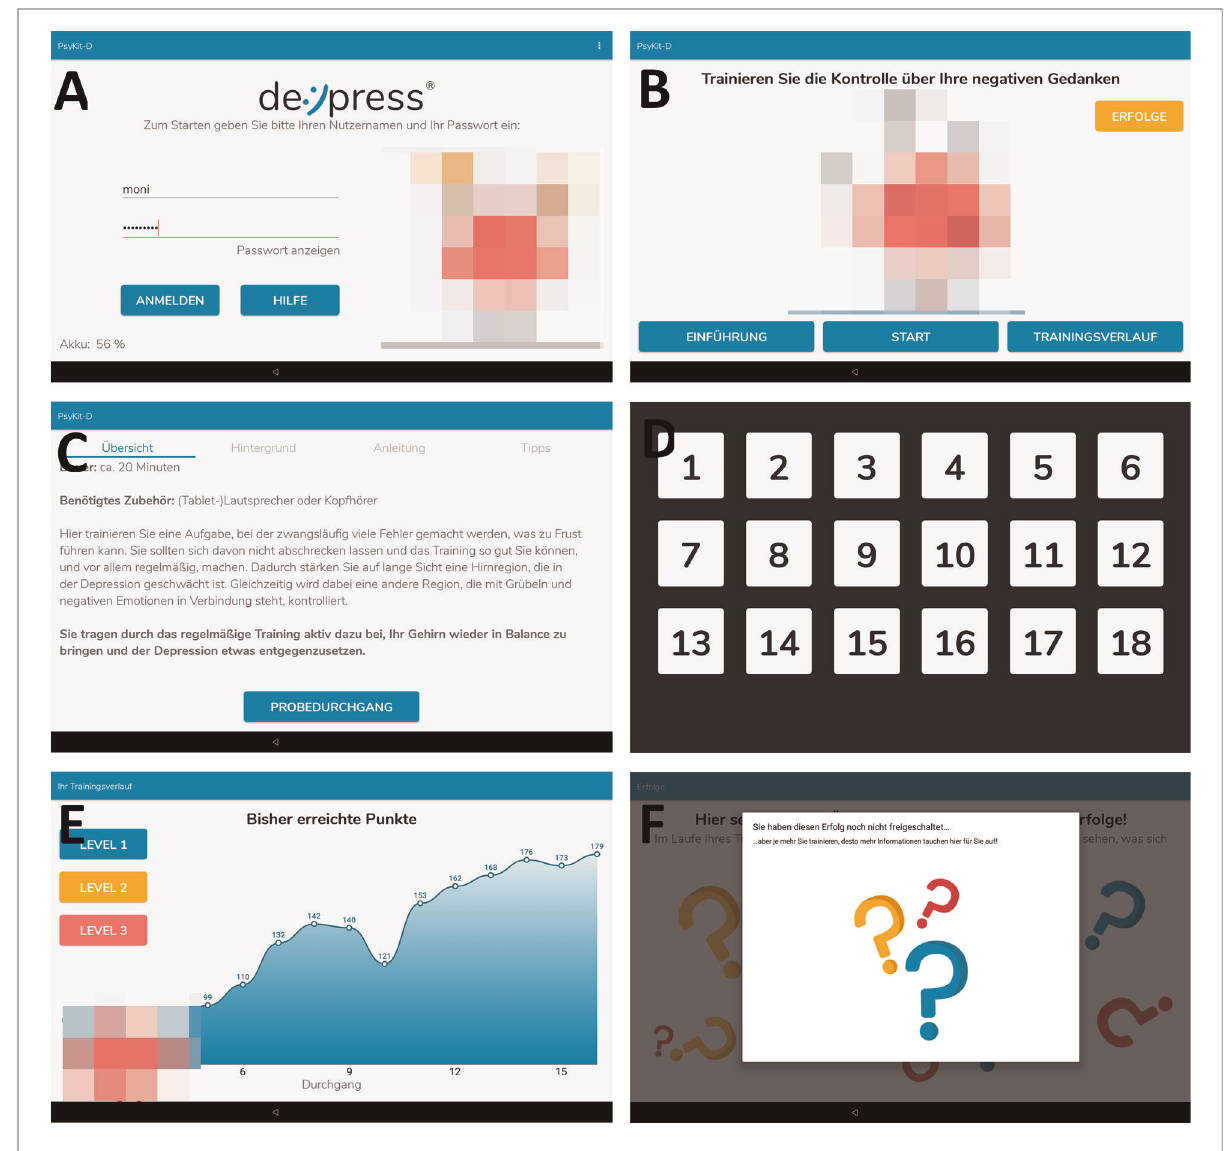
FIGURE 2 Screenshots from the IG app. ( A ) Login screen. ( B ) Training hub, from which participants were able to chose which area of the app they wanted to explore. ( C ) Introduction and instructions for the training. Furthermore, psychoeducative information was provided. ( D ) Keyboard layout during training. This layout shows the fi rst level with an ascending button layout. ( E ) Progression graph that shows the number of correct responses within each training session ( “ highscore ” ). ( F ) Achievements that can be unlocked during training. In this screenshot no achievements have been unlocked yet. The CG app consisted of screens A (without avatars), ( C,D ).